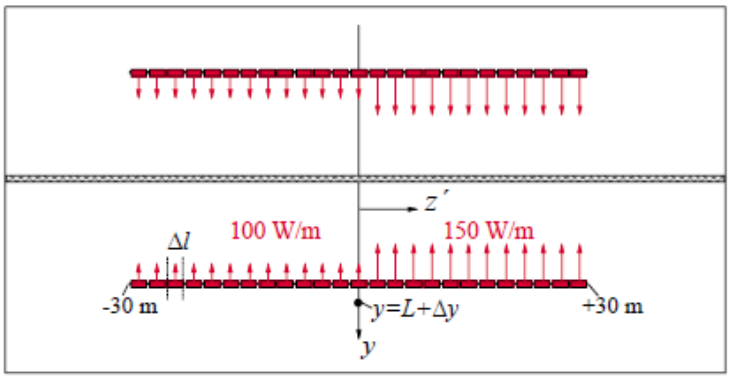
Figure 7. Finite line of point sources with locally varying losses ( L = 2.0 m; Δ l = 0.01 m; λ = 1.0 W/(K m)).